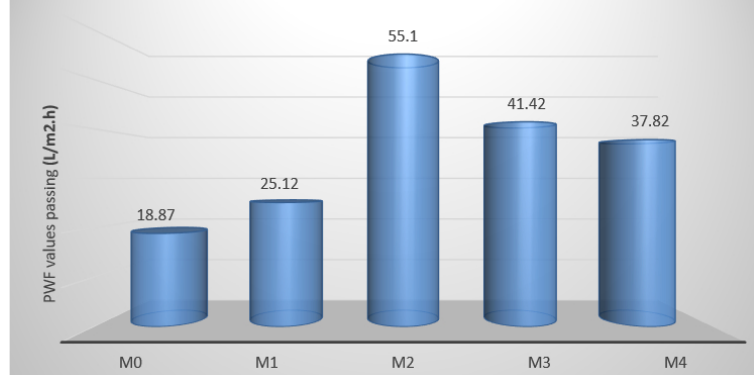
Figure 8. Pure water flux (PWF) of the synthesized membranes (pressure=5 bar and temperature=25±3 °C)